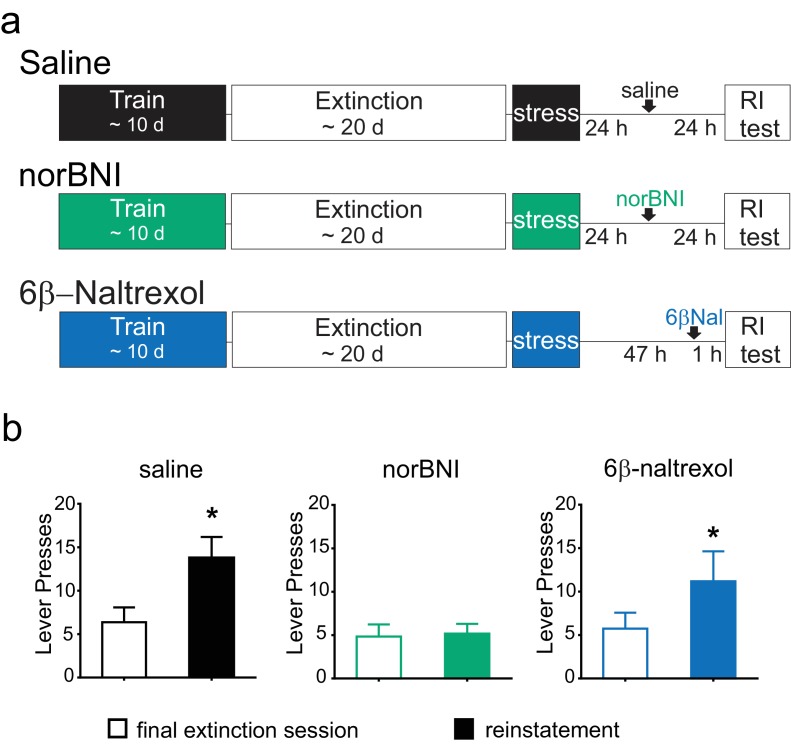
Post-stress rescue of reinstatement by norBNI but not 6β-naltrexol.(A) Experimental design. (B) Lever pressing during the final extinction session (white bar) and reinstatement session (colored bar). Saline (black): last extinction session: 6.4 ± 1.7 lever presses; reinstatement session: 13.8 ± 2.4 lever presses; n = 8, *p=0.011, paired t-test. norBNI (green): last extinction session: 4.8 ± 1.4 lever presses; reinstatement session: 5.2 ± 1.1 lever presses; n = 6, p=0.76, paired t-test. 6β-naltrexol (blue): last extinction session: 5.7 ± 1.8 lever presses; reinstatement session: 11.2 ± 3.4 lever presses; n = 11, *p=0.033, paired t-test.